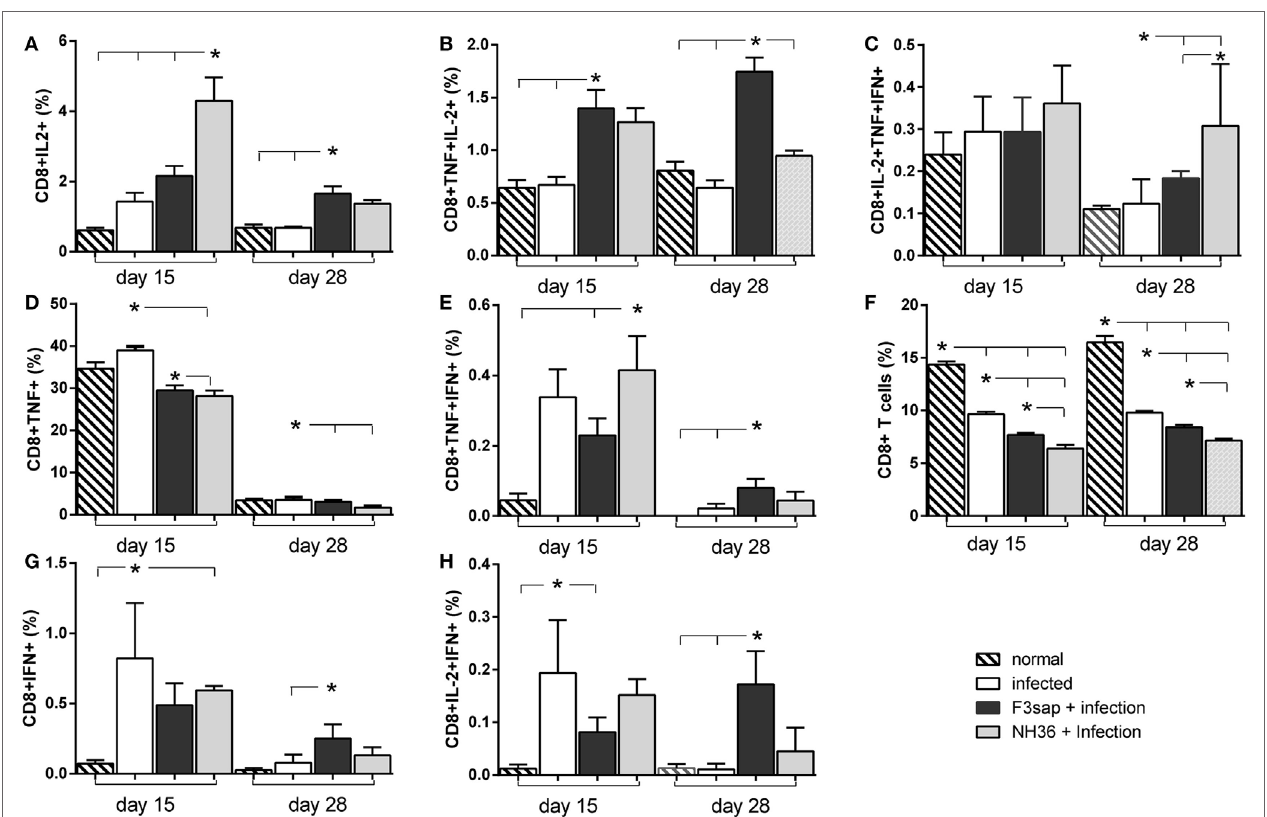
FigUre 10 | Cytokines expressed by CD8 + T lymphocytes in response to NH36. Effect of the F3 and NH36-vaccines on the frequencies of CD8 + IL-2 + (a) , TNF- α + (D) , IFN- γ + (g) , TNF- α + IL-2 + (B) , TNF- α + IFN- γ + (e) , IL-2 + IFN- γ + (h) , and IL-2 + TNF- α + IFN- γ + -secreting T cells (c) in response to the NH36 antigen, on day 15 and 28 post challenge. The total CD8 + T cell frequencies are also represented (F) . Bars represent the mean + SE values of two-independent experiments ( n = 5 mice per treatment in each experiment). Asterisks and horizontal lines show significant differences between treatments as disclosed by Mann–Whitney non-parametrical